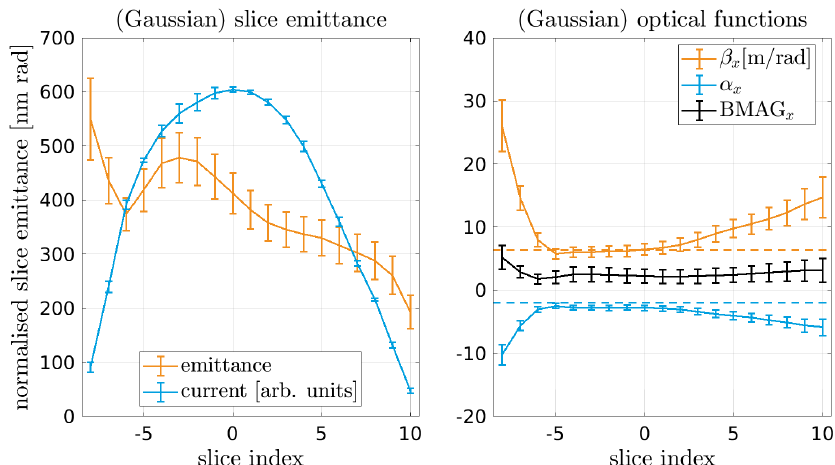
FIG. 14. The slice emittance along the bunch measured by the standard method used at the facility [13]. Black line in the right plot corresponds to the BMAG parameter [14].